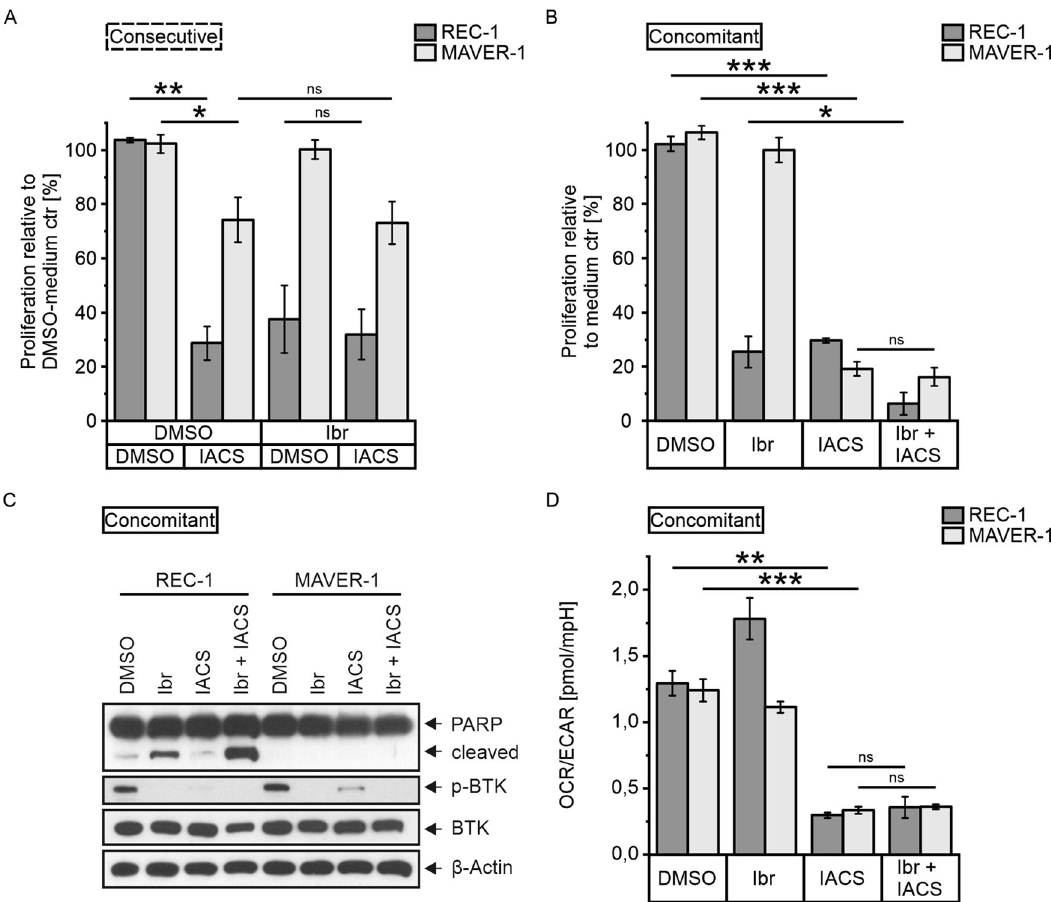
Fig. 2 Combination of ibrutinib and IACS-010759 treatment. A Consecutive treatment of REC-1 and MAVER-1 with 3 d ibrutinib pretreatment (400 nM or DMSO), followed by incubation of viable cells with 25 nM IACS-010759 or DMSO and 400 nM ibrutinib or DMSO according to pretreatment for 2 more days, and B Concomitant ibrutinib (400 nM) plus IACS-010759 (25 nM) treatment of REC-1 and MAVER-1 across 4 d; proliferation was assessed by 3-(4,5-dimethylthiazol-2-yl)-2,5-diphenyltetrazolium bromide (MTT) assay and percentages relative to medium control (ctr) pretreated with DMSO ( A ; N = 3) and relative to medium control ( B ; N = 4) are shown. C Western blot with PARP, p-BTK, BTK, and β -Actin as loading control (representative for N = 3; see supplementary Original Western Blots), and D Extracellular fl ux analysis showing oxygen consumption rate vs extracellular acidi fi cation rate ratios ( N = 4) of 3 d simultaneous treatment with 400 nM ibrutinib and 25 nM IACS-010759. Data are shown as mean ± SEM. Signi fi cance was determined by two-sided Student ’ s t -test or a Welch ’ s t -test, for equal or unequal variances, respectively. * P < 0.05, ** P < 0.01, *** P < 0.001, P > 0.05 not signi fi cant (ns). Signi fi cance is indicated for relevant (ibrutinib vs ibrutinib + IACS, P = 0.035; Fig. 2B). This was accompanied by increased apoptosis as indicated by higher PARP cleavage after 03 d treatment (Fig. 2C, supplementary Original Western Blots). In MAVER-1, IACS impaired proliferation (DMSO vs IACS, P < 0.001) and the effect of the combination was similar to IACS only treatment (IACS vs ibrutinib + IACS, P = 0.500), as ibrutinib had no effect (Fig. 2B). Loss in proliferation due to 04 d of IACS was higher in MAVER-01 than in REC-01 (DMSO vs IACS, P < 0.001 for REC-1), which was opposite to 02 d treatment described above and re fl ected the proliferation course of the two cell lines across IACS treatment, as shown by the kinetics (Supplementary Fig. 2A). As PARP was not inactivated following 03 d IACS only treatment in both cell lines, reduced proliferation was not associated with increased apoptosis (Fig. 2C, supplementary Original Western Blots). In contrast, IACS affected activation of BTK, resulting in reduced (MAVER-1) or no phosphorylation (REC-1). The extracellular fl ux analysis revealed low oxygen consumption rate (OCR) vs extracellular acidi fi cation rate (ECAR) ratios in both cell lines following 03 d incubation with IACS (DMSO vs IACS, P = 0.002 for REC-01 and P < 0.001 for MAVER-1; Fig. 2D). Even though